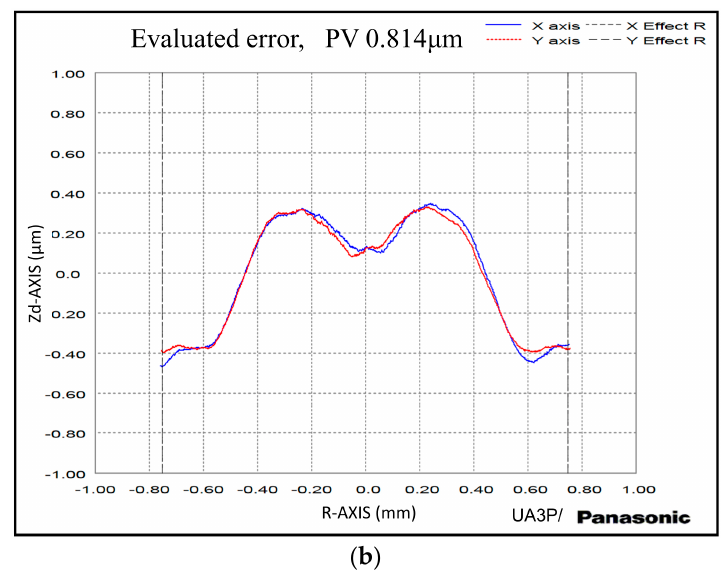
Figure 10. The form error of ( a ) the mold inserts and ( b ) molding lenses.